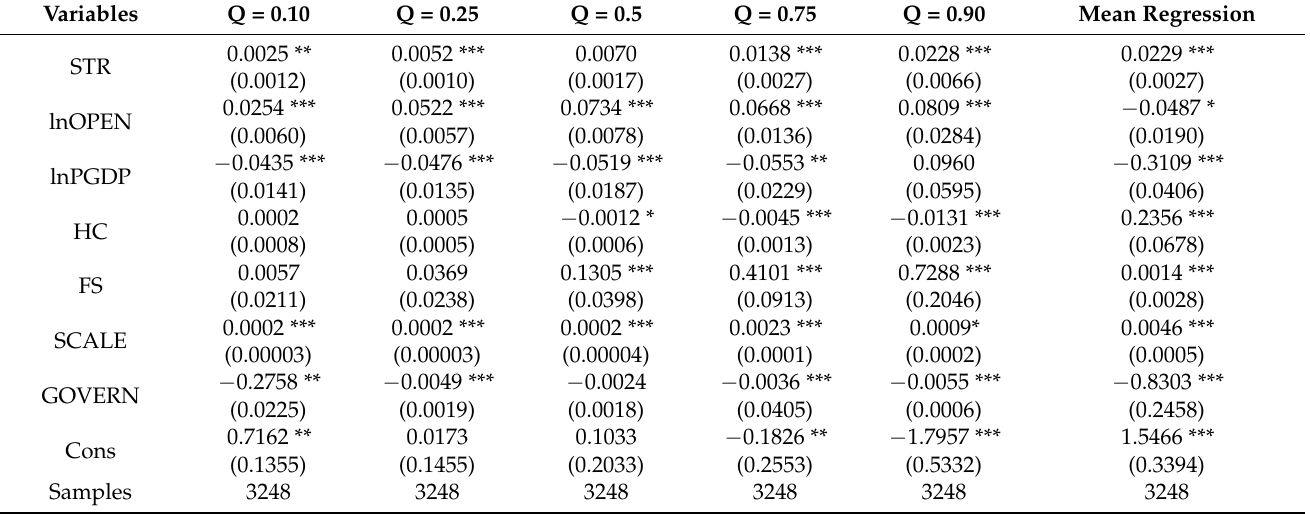
Table 3. Quantile regression